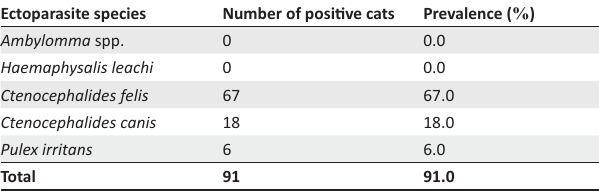
TABLE 2: Overall prevalence of ectoparasites on examined cats ( n = 100) in